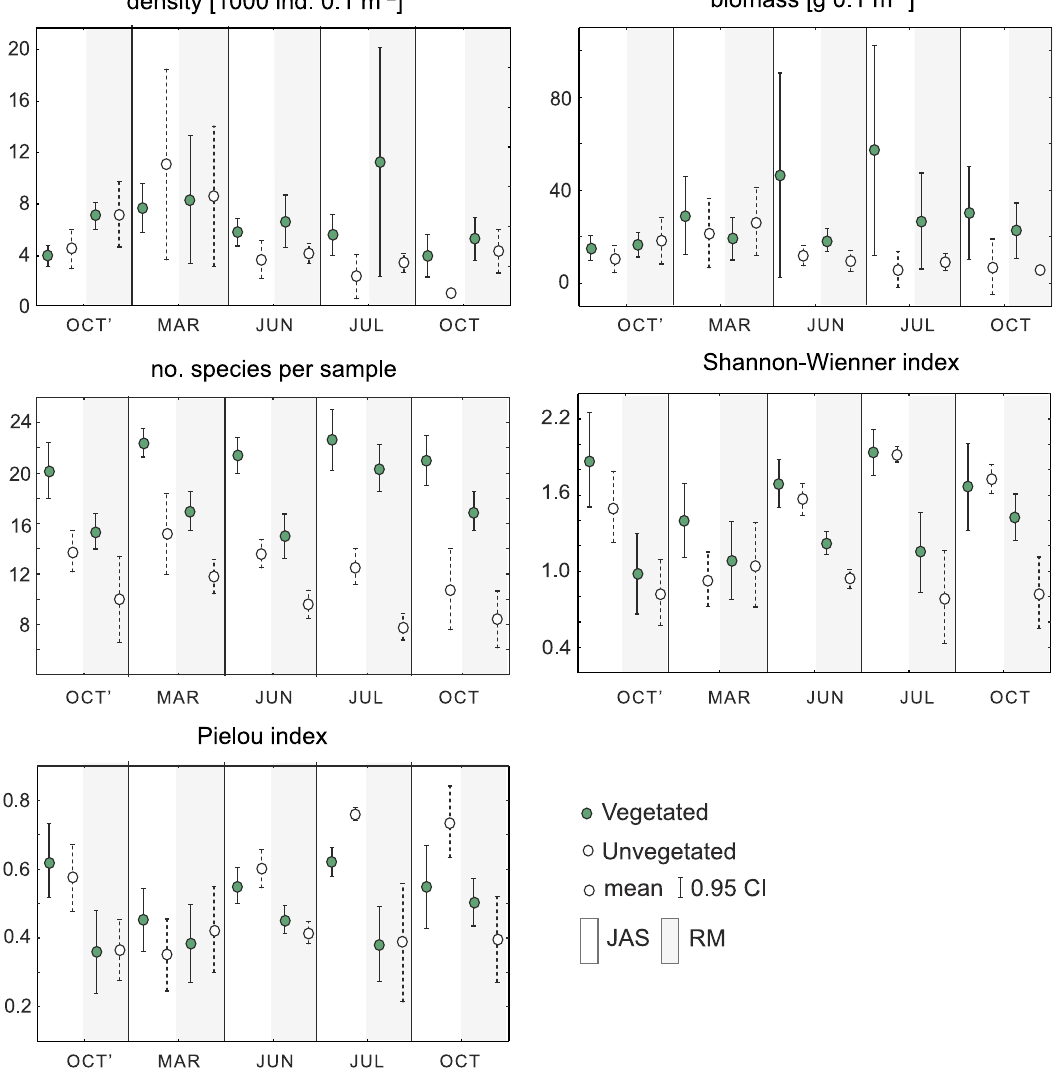
Figure 3). PERMANOVA did not detect any significant effect of bottom type on J (Table 1). Station, month, and bottom type were sources of significant difference in species diversity ( H ), and station had the strongest effect (as indicated by the highest CV). H at the JAS site was 1.62 on average ( 6 0.33 SD), while at RM it was 1.03 ( 6 0.27 SD). H was significantly higher on vegetated bottoms than on bare sand, but this effect did not interact with the effect of month (Table 1). PERMANOVA identified significant effects (at P , 0.001) of Bt, St, and Mt on macrobenthic community composition (Table 2). Bottom type had the strongest effect when pr/ab or double root transformed data were analyzed, as indicated by the highest CV values and illustrated on the MDS plot of group averages (Figure 5). Groups defined by bottom type and site could be easily discriminated on the PCO plot (Figure 6). Samples collected